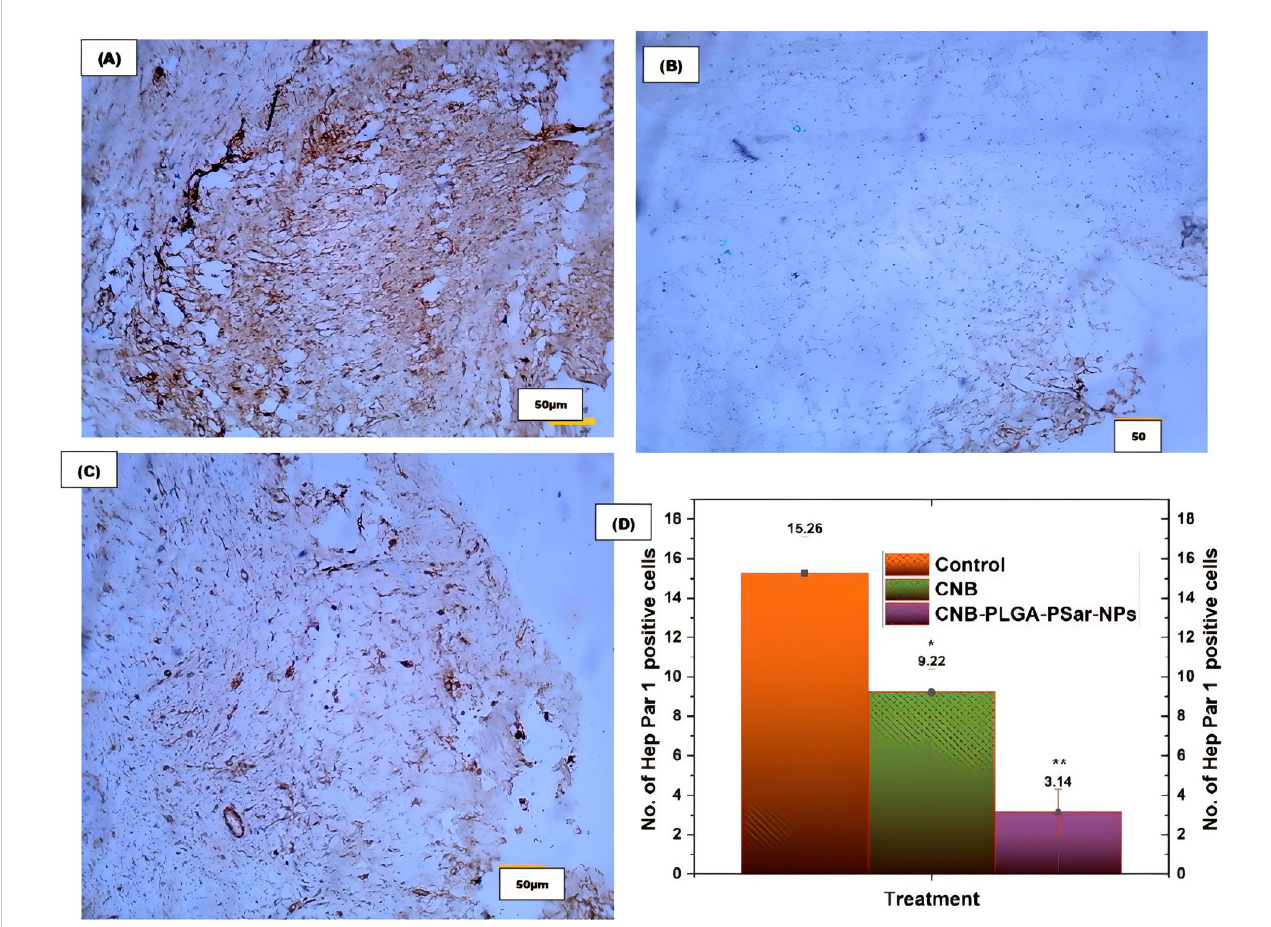
FIGURE 11 Immunohistochemical study for the Hep Par 1 expression by (A) control (PBS buffer treated), (B) free CNB, and (C) CNB-PLGA-PSar-NPs treated tumours. (D) The quantitative analysis of IHC results. Statistical comparisons were made using t-test; * partial signi fi cance; p < 0.001; ** moderately signi fi cance < 0.000. The treatment was compared with control (PBS buffer